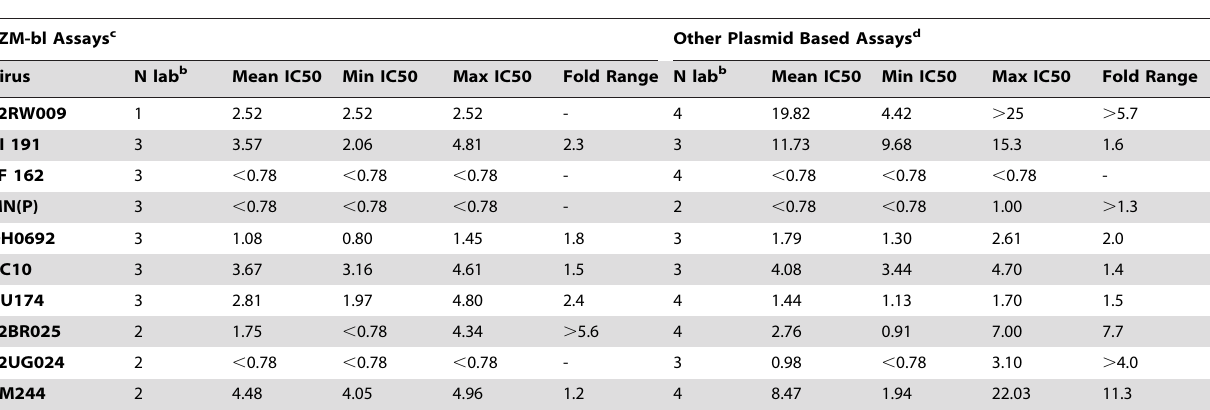
Table 4. Inter-Laboratory comparisons with TriMab a